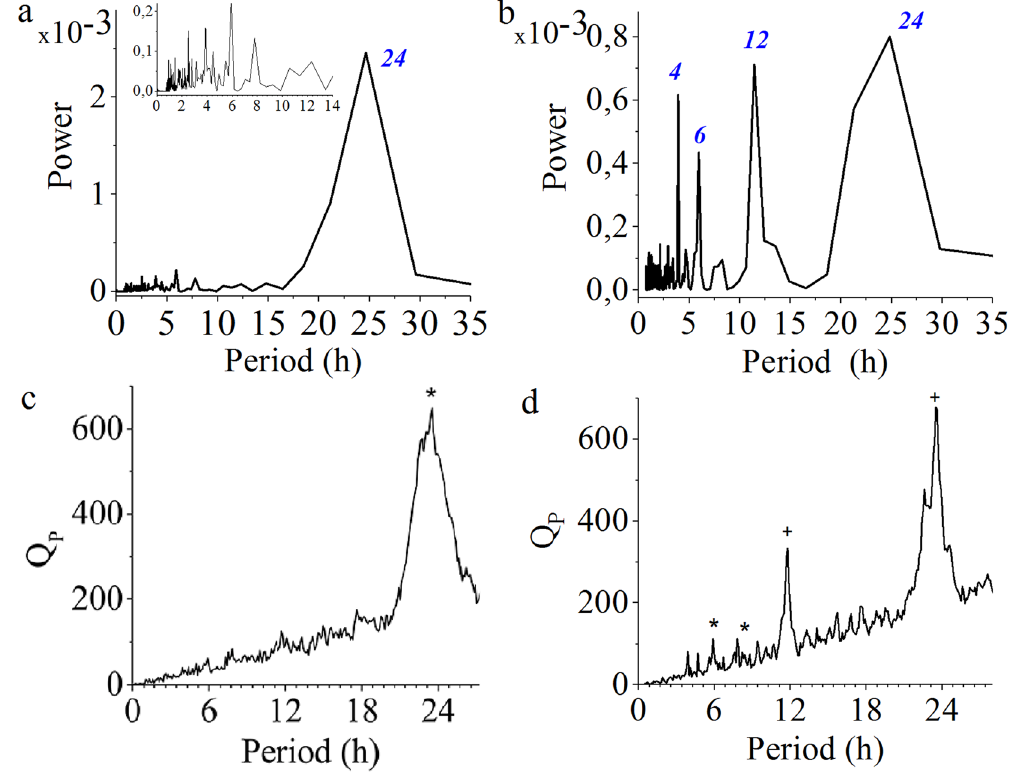
Figure 2. Analysis of rhythms in locomotion time series. Analytical examples of ( a,b ) power spectrum, and ( c,d ) Enright’s method corresponding to two time series of locomotor activity of female Japanese quail in a home-cage environment. ( a,c ) The time series analyzed clearly present circadian rhythms but do not show evidence of ultradian rhythms. Blue italic numbers represent the period in hours of the peaks. ( b,d ) Analysis of the same time series depicted in Fig. 1b. Of note is that the two methods detect both circadian and ultradian rhythms in this time series. Complete high-resolution time series (10 6 data points) were used for power spectrum. To reduce the impact of noise in the analysis, we applied the Enright’s method to actograms (6 min bins). * Statistically significant peaks (P < 0.001). + These peaks are multiples of 6 and therefore the algorithm does not estimate